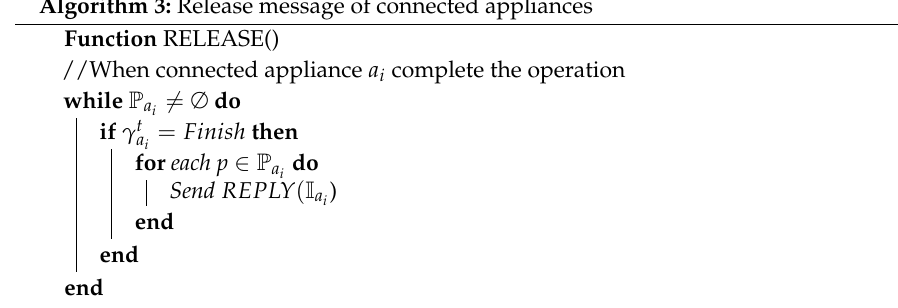
Algorithm 3: Release message of connected appliances